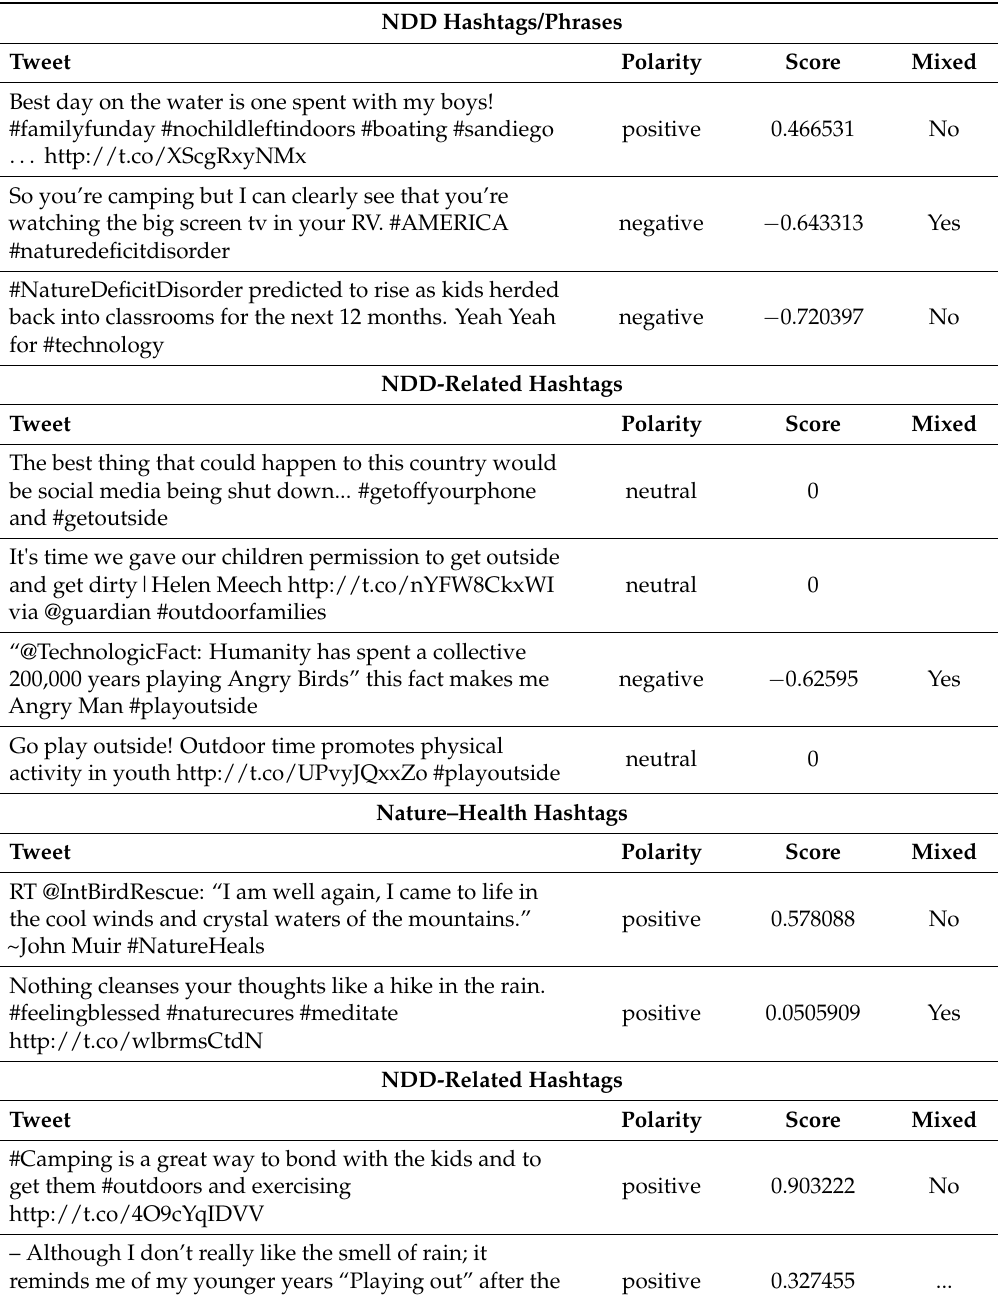
Table 2. Sample tweets processed by